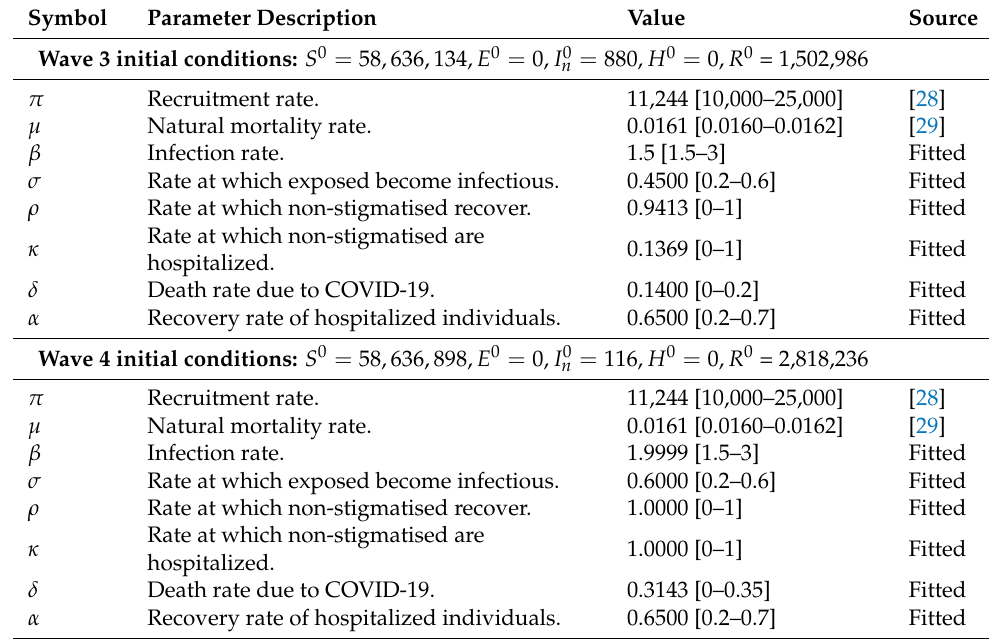
Table 2. Parameter values for COVID-19 waves 3 and 4. While, some of the parameter values were obtained from literature, those with some given intervals were estimated to be between the minimum and maximum values depicted in the